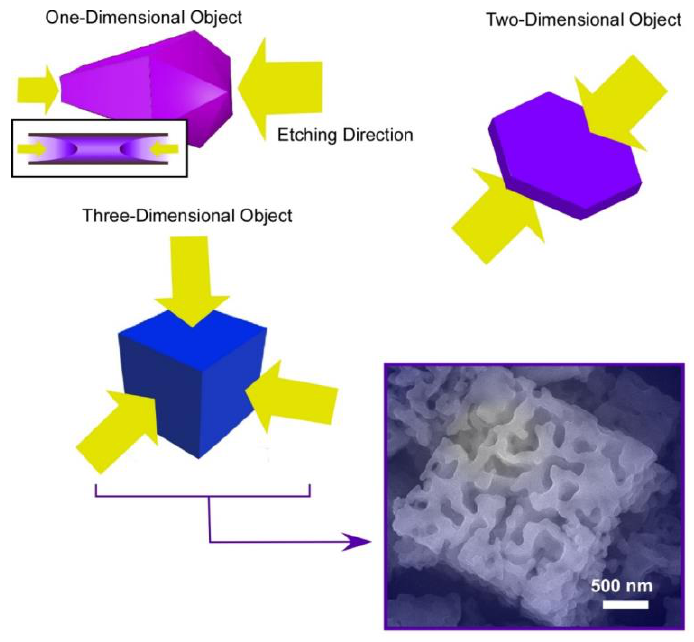
Figure 6. Chemical etching using ethylene diamine for preformed assembling objects in different dimensions: one-dimensional C 60 nano-rods, two-dimensional C 60 nano-sheets, and three-dimensional C 70 micro-cubes.